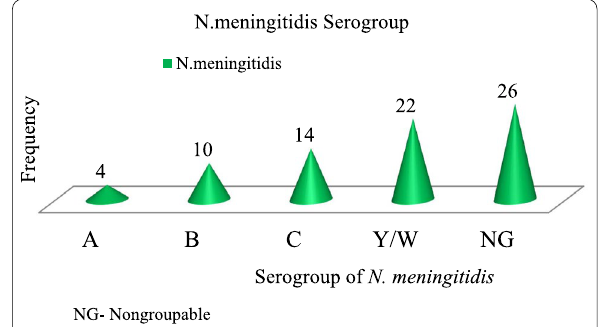
Fig. 3 Characteristic of isolates serogroup, Jimma Ethiopia,